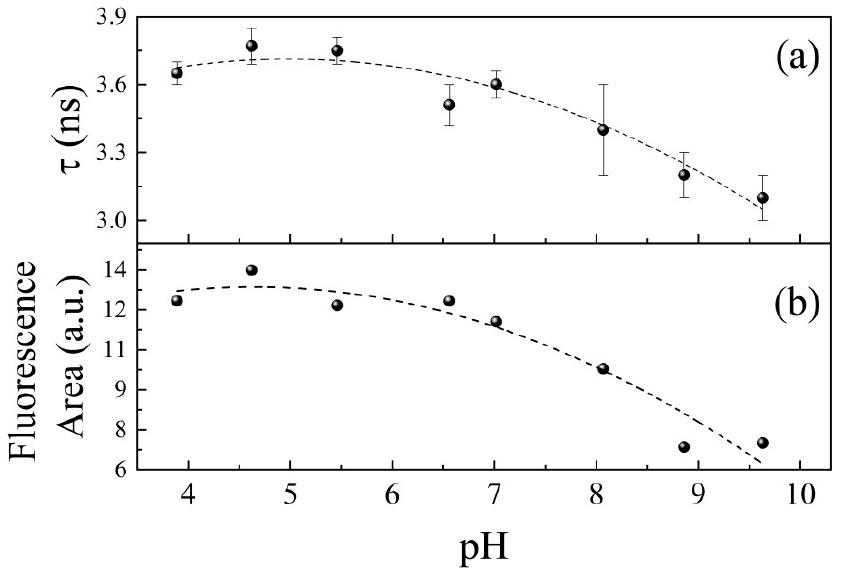
Figure 9. Fluorescence ( a ) lifetime and ( b ) spectra areas ( λ = 532 nm, and P e ≈ 50 mW) for natural dye that was inserted in milk as a function of the pH value ( L = 1 cm). The dashed adjustment is shown for eye guidance only. Table 3. Applications of natural dyes as pH indicators in foods.